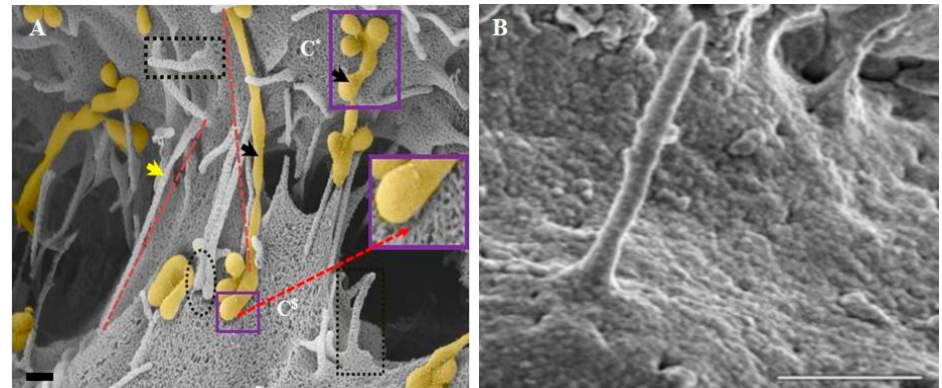
Figure 9. TENT development on the apical surface of BEC bEnd5 plasma membrane surfaces. ( A ) Early/primordial TENT development on the plasma membrane surface of the BEC at high magnification, represented in the black perforated boxes. C* denotes the membrane of cell one, C $ denotes cell two, the yellow arrow denotes a fully formed TENT structure extending across the paracellular space between two adjacent BECs and the black arrows denotes nanovesicle-induced TUNT structures. Scale bar = 200 nm [31]. ( B ) A SEM photomicrograph of proposed primary endothelial cilium at high magnification. Scale bar = 1 µm [71]. Note the similarity between the primordial TENT (perforated square) in ( A ) to the postulated cilium in ( B ).